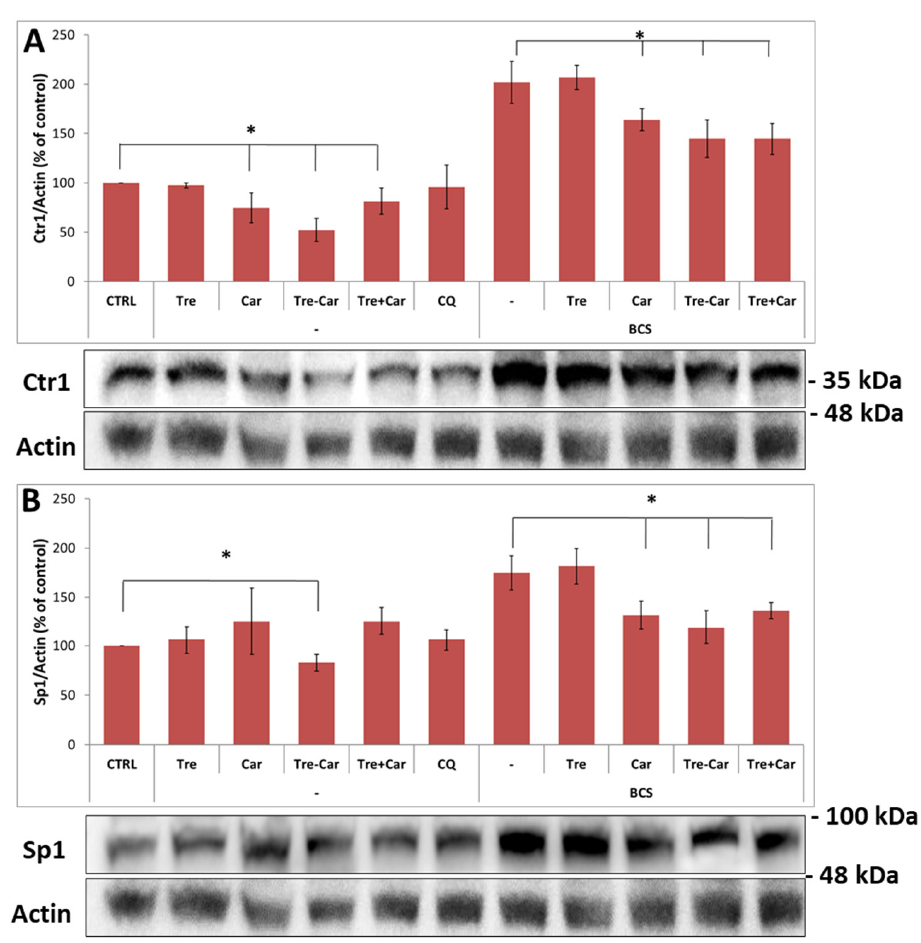
Figure 3. Car, Tre-Car or Tre + Car mixture affects the Ctr1 ( A ) and Sp1 ( B ) expression. Starved PC12 cells were stimulated with 5 mM Car, Tre-Car, Tre + Car mixture or 10 µ M CQ for 24 h in RPMI-1640 complete medium supplemented with 1% of fetal bovine serum (FBS), with or without 50 µM BCS. The expression level of Ctr1 and Sp1 is reported as ratio over the Actin (* p ≤ 0.05 versus the respective control/treatment). Dashes to the right of the membrane bands show positions of prestained molecular mass marker.